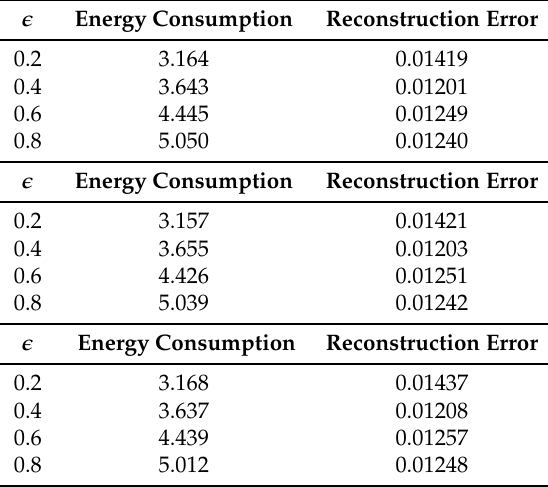
Table 2. Performances by Different (cid:101) for round 1, 3, 5.